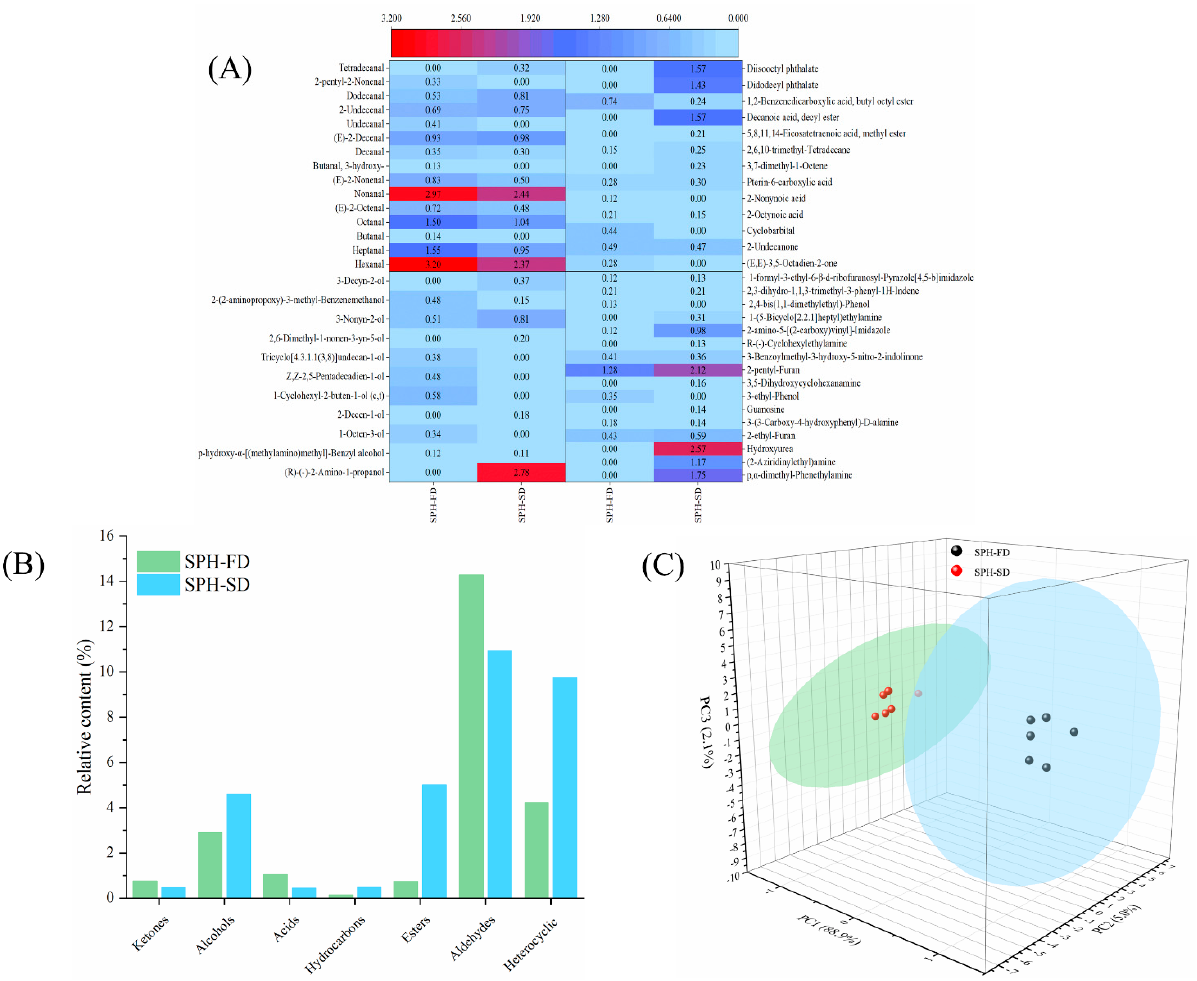
Figure 4. Heatmap ( A ), contents of various classes of volatile substances ( B ), and PCA analysis ( C ) of volatile compounds of SPH-SD and SPH-FD. volatile compounds of SPH-SD and